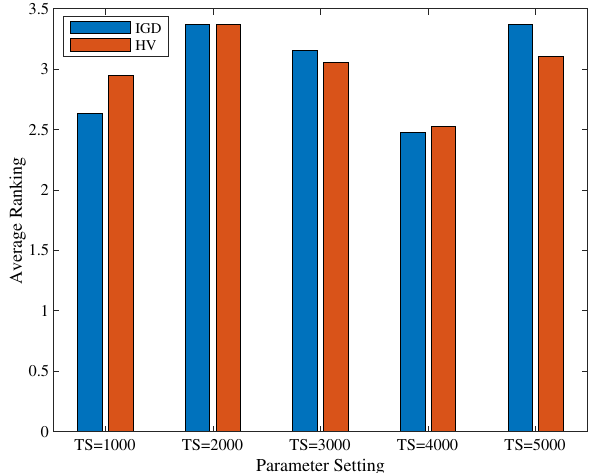
Fig. 10 Average ranking for five versions of parameter setting on 19 instance in terms of IGD and HV values